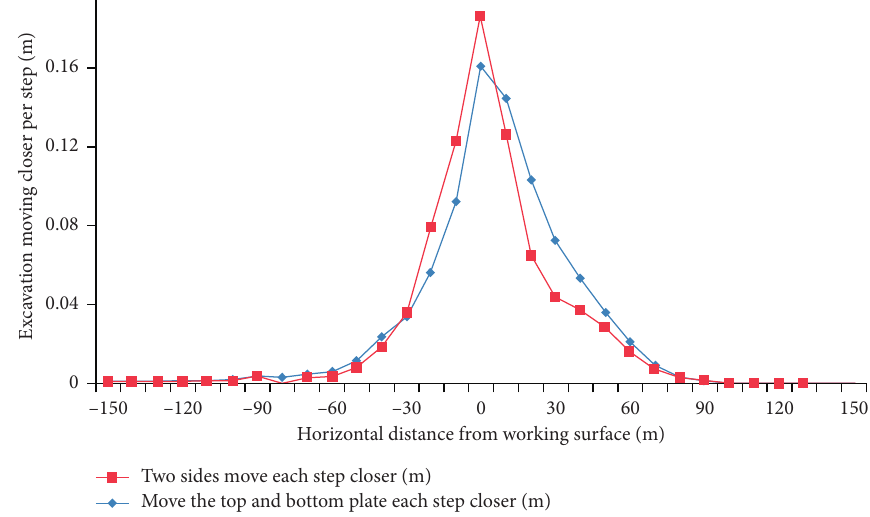
Figure 9: Deformation of roof and floor and sides per mining